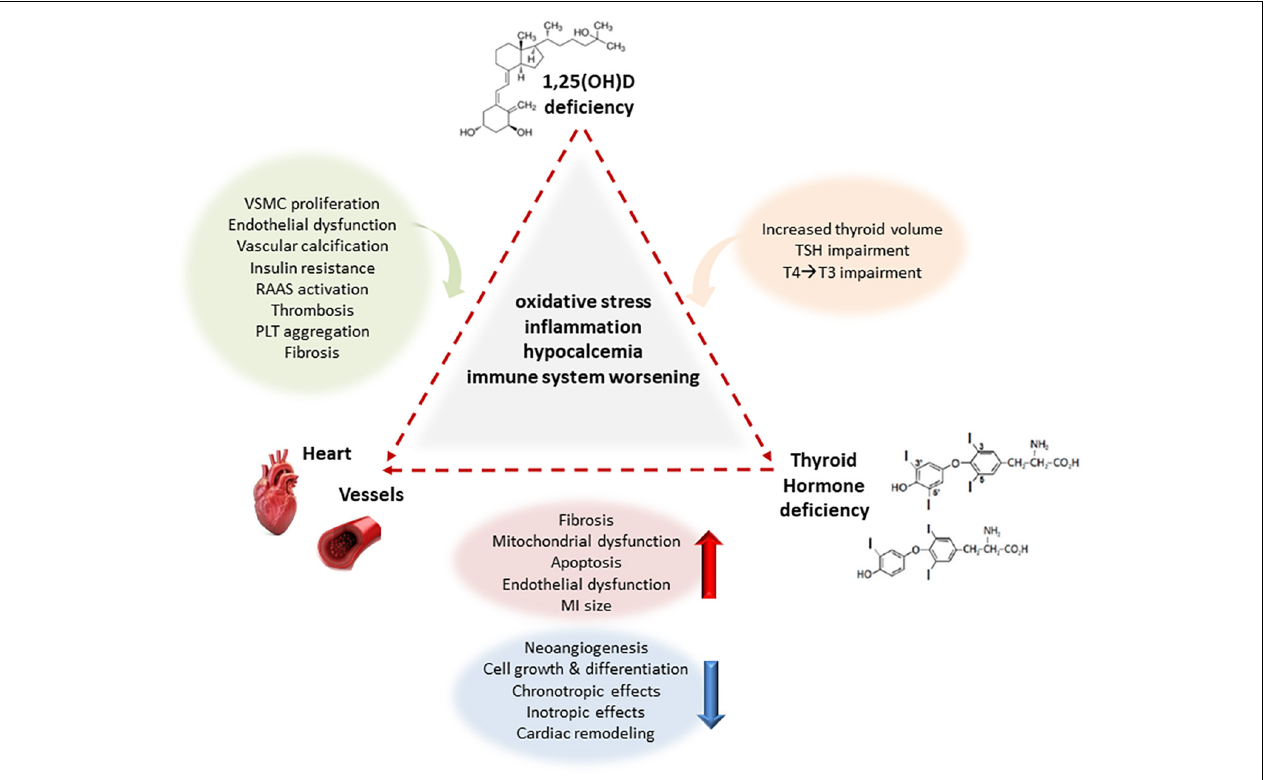
FIGURE 1 | Main interactions between deficiency of vitamin D and THs on the CV system creating a complex network in a adverse vicious circle. Under the effect of underlying common mechanisms related to oxidative stress, inflammation, hypocalcemia and immune system worsening, Vitamin D deficiency induces VSMC proliferation, endothelial dysfunction, facilitates vascular calcification, and promotes insulin resistance, RAAS activation, thrombosis, PLT aggregation, and fibrosis to the CV system, and increased thyroid volume, TSH and T4/T3 impairment to thyroid, whereas THs deficiency also induces fibrosis, mitochondrial dysfunction, apoptosis, endothelial dysfunction, reduces chronotropic and inotropic effects, increasing MI size in experimental models, and reducing eNOS expression and activity, angiogenesis, cellular growth and differentiation, and cardiac remodeling at cardiovascular level. VSMC vascular smooth muscle cells, eNOS endothelial nitric oxide synthase, RAAS renin–angiotensin–aldosterone system, MI myocardial infarction, TSH thyroid stimulating hormone, T3 triiodothyronine, T4